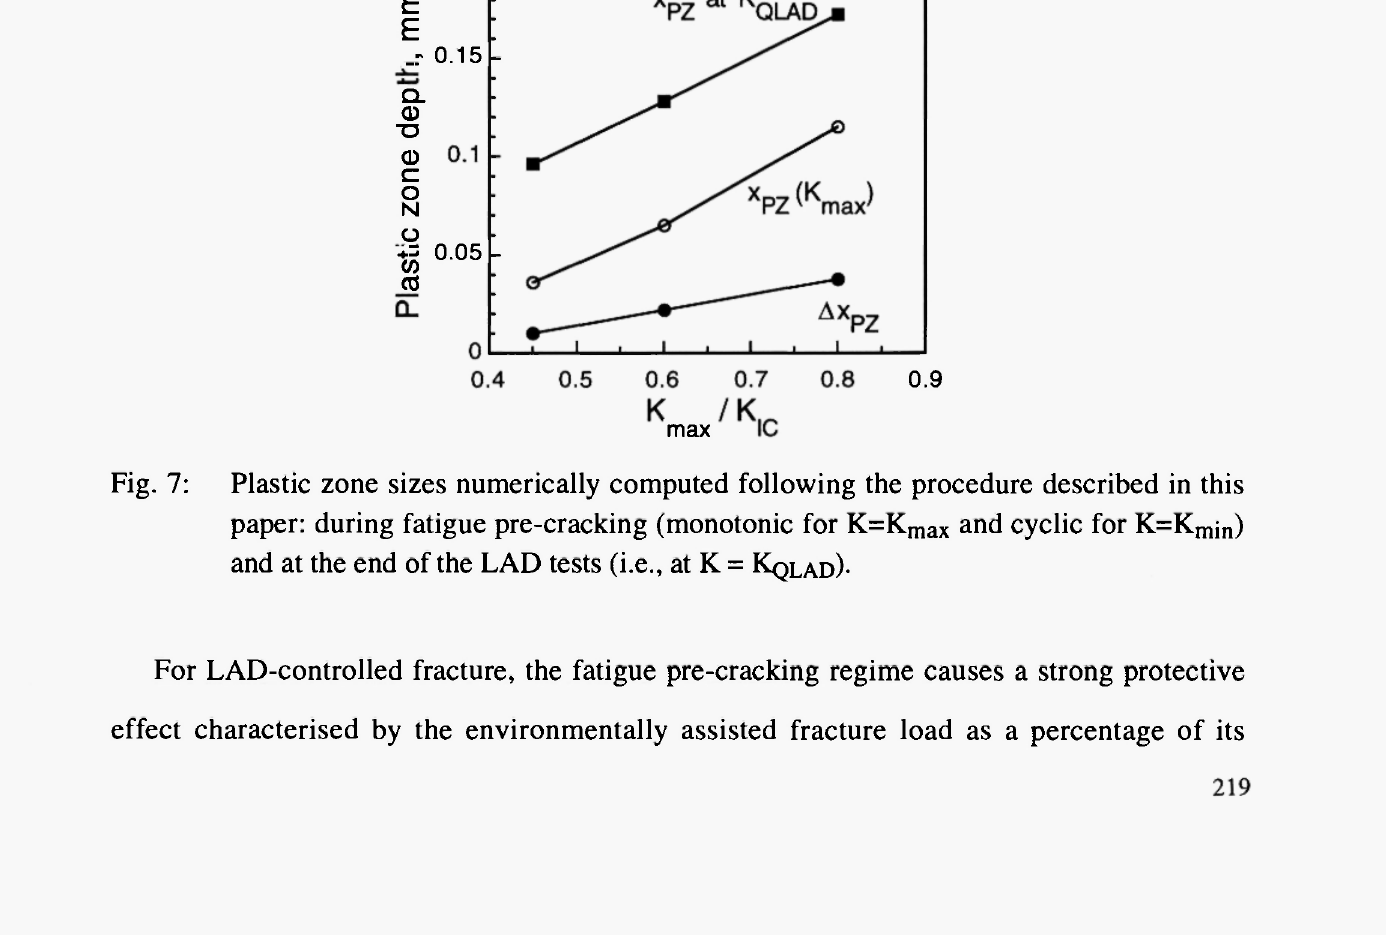
For LAD-controlled fracture, the fatigue pre-cracking regime causes a strong protective effect characterised by the environmentally assisted fracture load as a percentage of